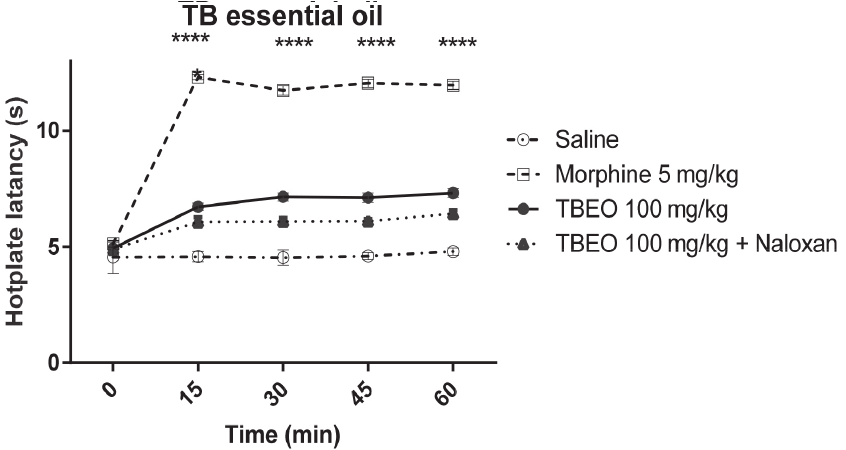
FIGURE 2 - Opioid independence analgesic activity of TBEO. Data represent Mean ± SEM of six to eight animals in each group. ****P < 0.0001 compared with the control group.